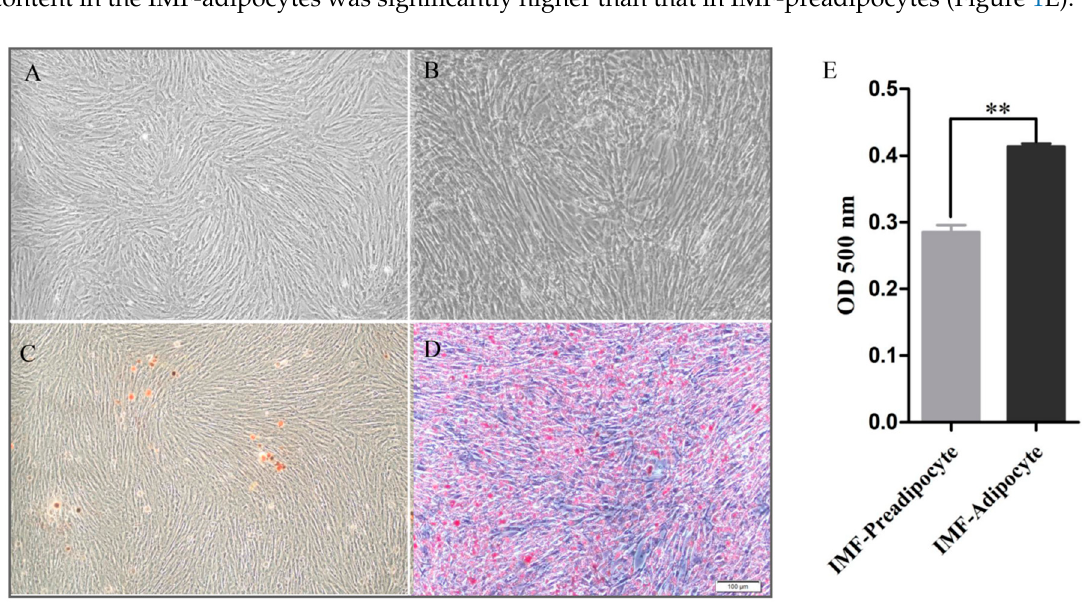
Figure 1. Introduction of intramuscular preadipocytes in vitro. ( A ) IMF (intramuscular fat)-preadipocytes. ( B ) Oil Red O staining of IMF-preadipocytes. ( C ) IMF-adipocytes. ( D ) Oil Red O staining of IMF-adipocytes. ( E ) Triacylglycerol (TG) content of IMF-preadipocytes and IMF-adipocytes group. Data is shown as mean ± SE. ** p < 0.01.